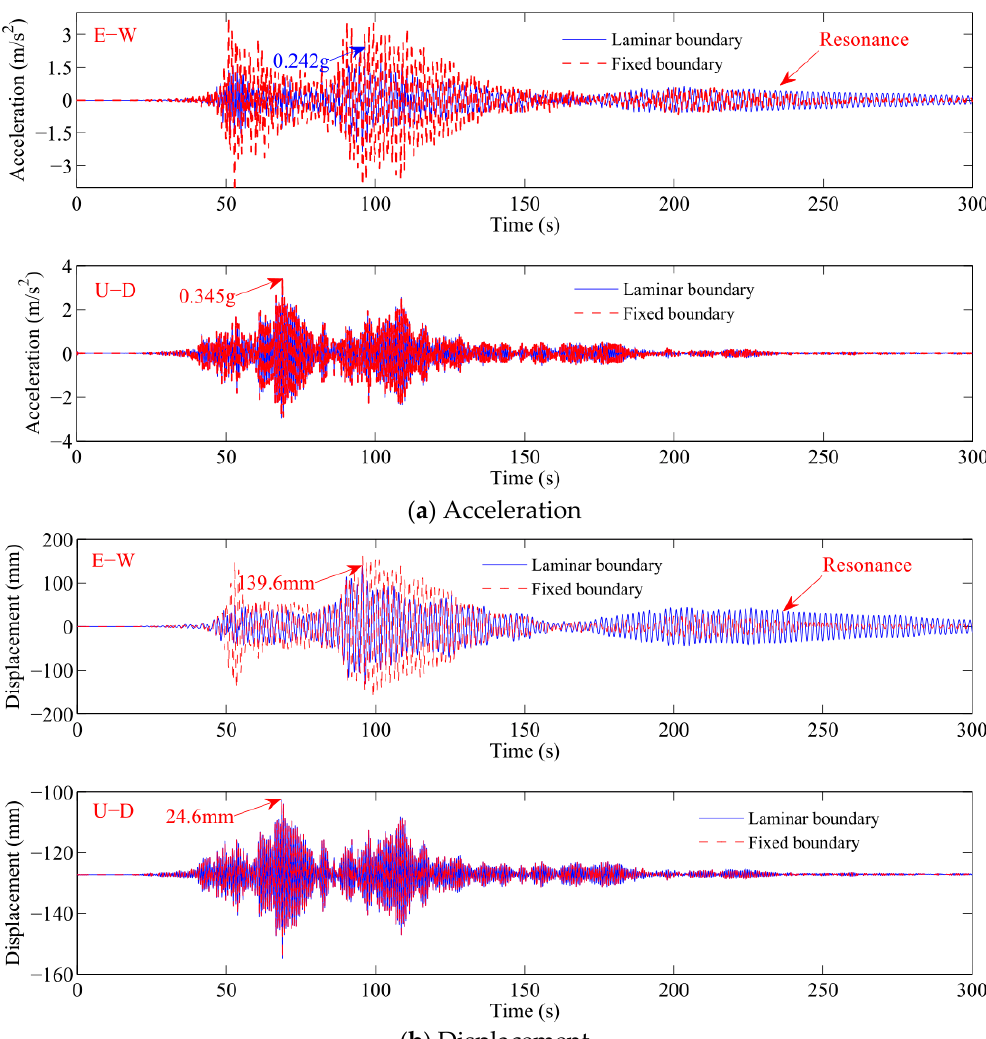
Figure 10. Effect of the fixed lateral side boundary on the dynamics of pipeline. Figure 10. E ff ect of the fixed lateral side boundary on the dynamics of pipeline. It is shown that there is a significant adverse e ff ect of the fixed lateral boundary condition on the horizontal